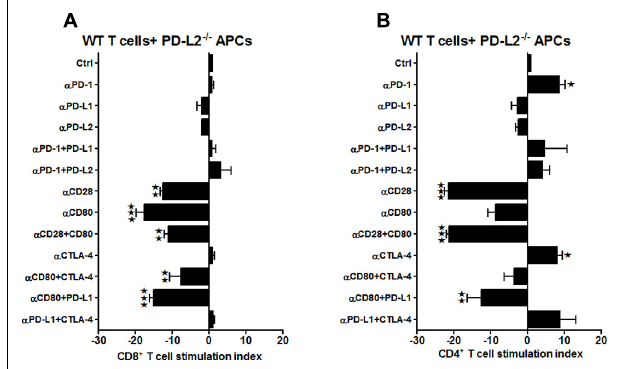
FIGURE 6 | Presence of PD-L1 onAPCs is as important as it is onT-cells, while expression of PD-L2 is crucial onAPCs ofWT mice, subjected to MCAO. T-cells were purified, by negative sort, from the spleens of MCAO-subjectedWT mice, by labeling with specific microbeads and separating on the AutoMACS TM .The purifiedT-cells were CSFE-labeled and then cultured with non-T-cells from PD-L2 − / − mice at a 1:1 ratio (T:APC) in the presence of anti-CD3 antibody (2.5 μ g/mL; baseline) and other neutralizing Abs (10 μ g/mL) to co-stimulatory molecules, in 96-well plates. After 72 h of culture, cells were washed and evaluated by FACS Calibur for A CD8 + and (B) CD4 + T-cell expression and CFSE dilution. Data represent the stimulation indices of the CD8 and CD4T-cells in the presence of neutralizing Abs as compared to the control (T:APC + anti-CD3 Ab) condition).The data are represented such that the baseline value is 1 and all other values are adjusted relative to the baseline. Data presented are representative of splenocytes obtained from eightWT, six PD-L1 − / − and six PD-L2 − / − mice with least three separate experiments and each experiment comprising duplicates or triplicates of the given neutralizing Ab condition. Significant differences between sample means are indicated as * p ≤ 0.05, ** p ≤ 0.01 and *** p ≤ 0.001 as compared to the baseline condition.